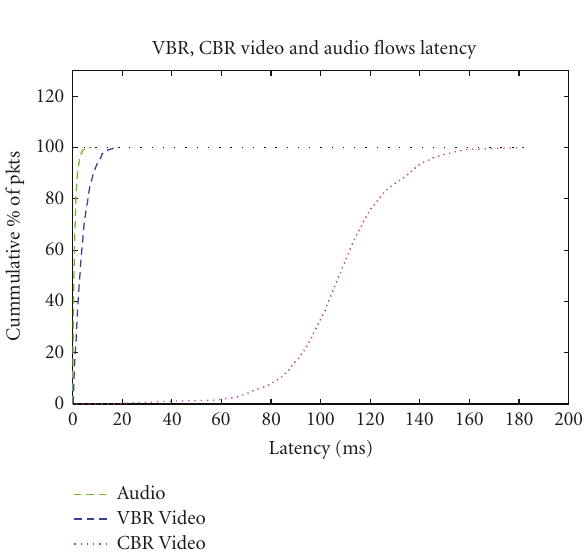
Figure 12: Latency distribution for EDCA.